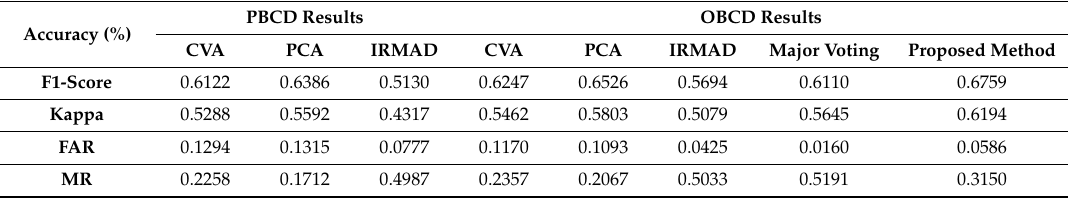
Table 1. Accuracy assessment of change detection results of the first experiment.